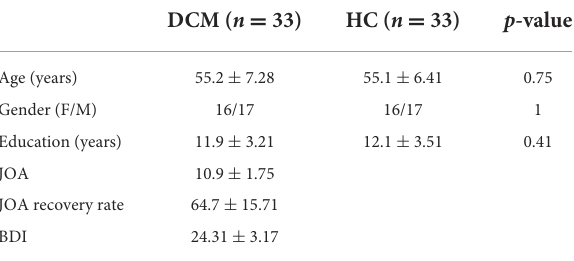
TABLE 1 Coordinates for ventral and dorsal striatal regions of interest. Region of interests